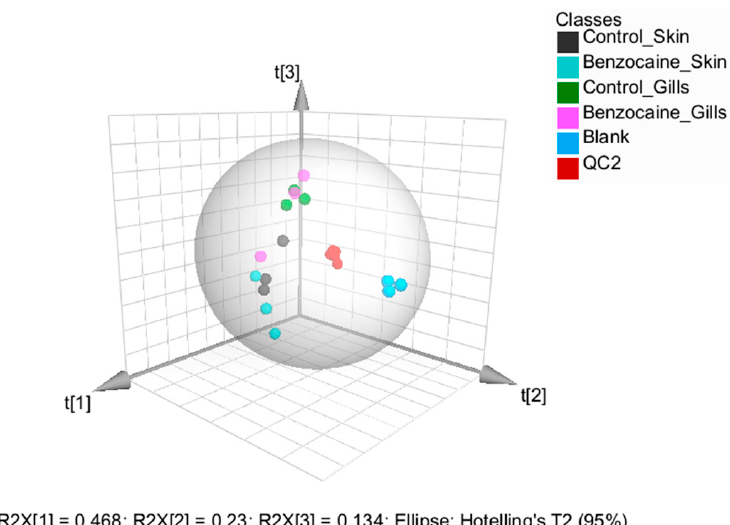
Figure 5. 3-D scores plot from unsupervised principal component analysis based on Pareto-scaled and log-transformed data obtained using the AbsoluteIDQ ® p400 HR kit. The first three components explain 83% of the total variation. The plot shows that the observations cluster primarily according to the type of tissue mucus was collected from (i.e., skin or gill) and not according to the euthaniza- tion method.